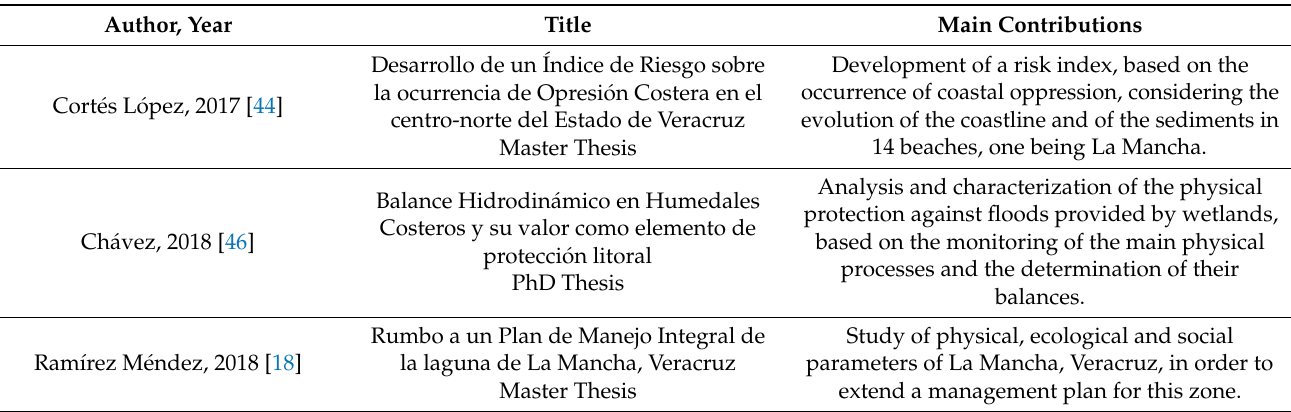
Table A2. List of relevant theses of La